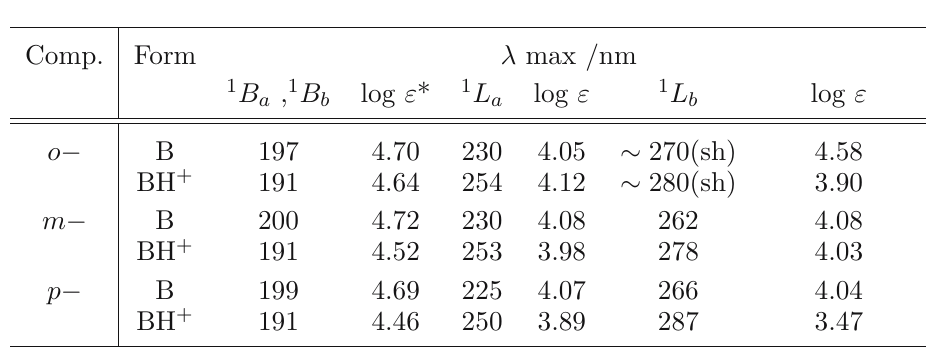
Table 1 Experimental transitions in the UV spectra of